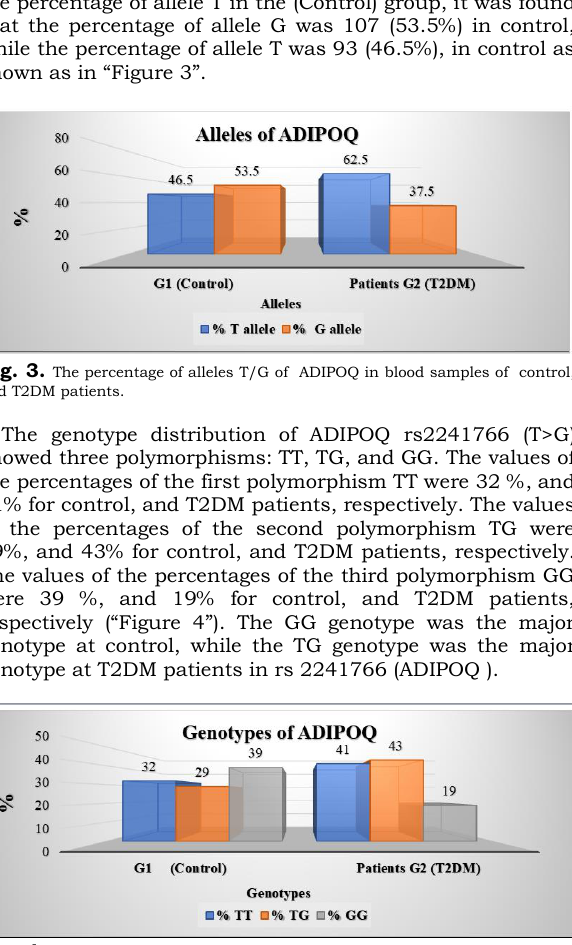
Fig. 4. The percentage of TT, TG, and GG genotypes of ADIPOQ in samples of control, and T2DM patients.